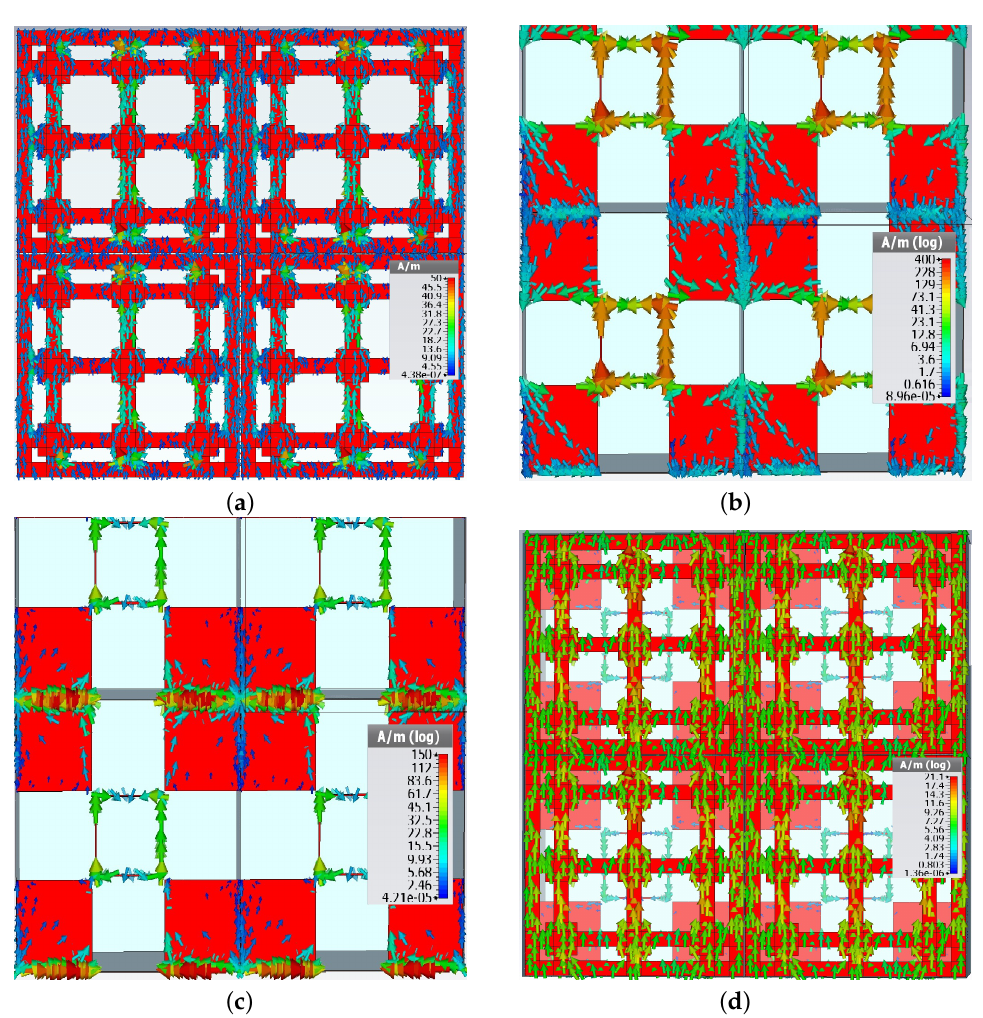
Figure 4. Field images of surface current density for the periodic surface with: ( a ) Face 1 only present, at 6.87 GHz; ( b ) Face 2 only present, at 11.58 GHz; ( c ) Face 2 only present, at 15.06 GHz. ( d ) View of Face 1, when both metallizations are present, at 6.74 GHz. The use of 2 × 2 configuration is preferred since it allows a better appreciation of the field distribution between adjacent unit cells.